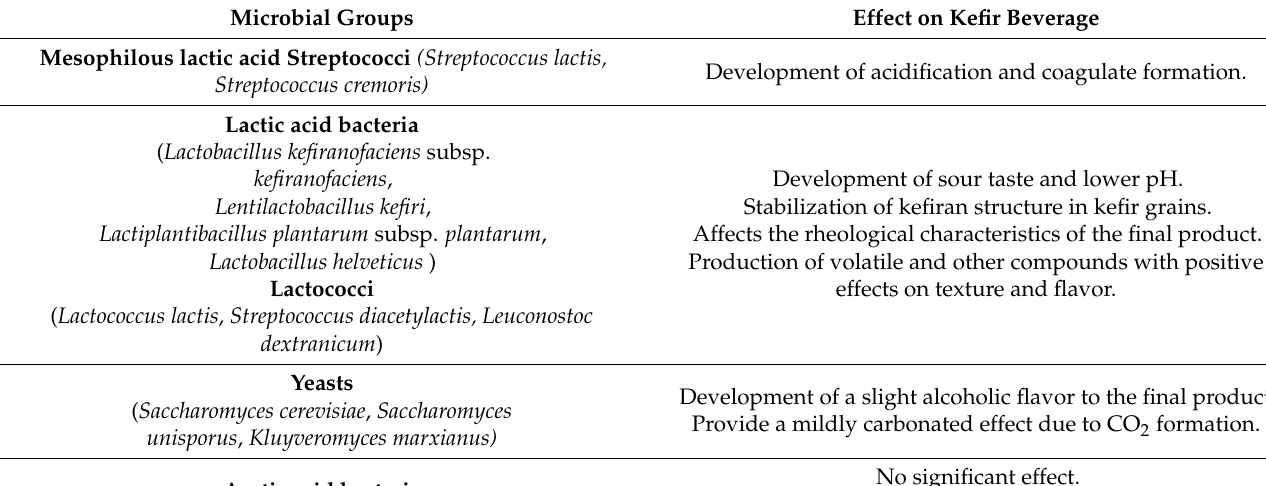
Table 2. Effect of different microbial groups on sensory characteristics of kefir beverages. Microbial